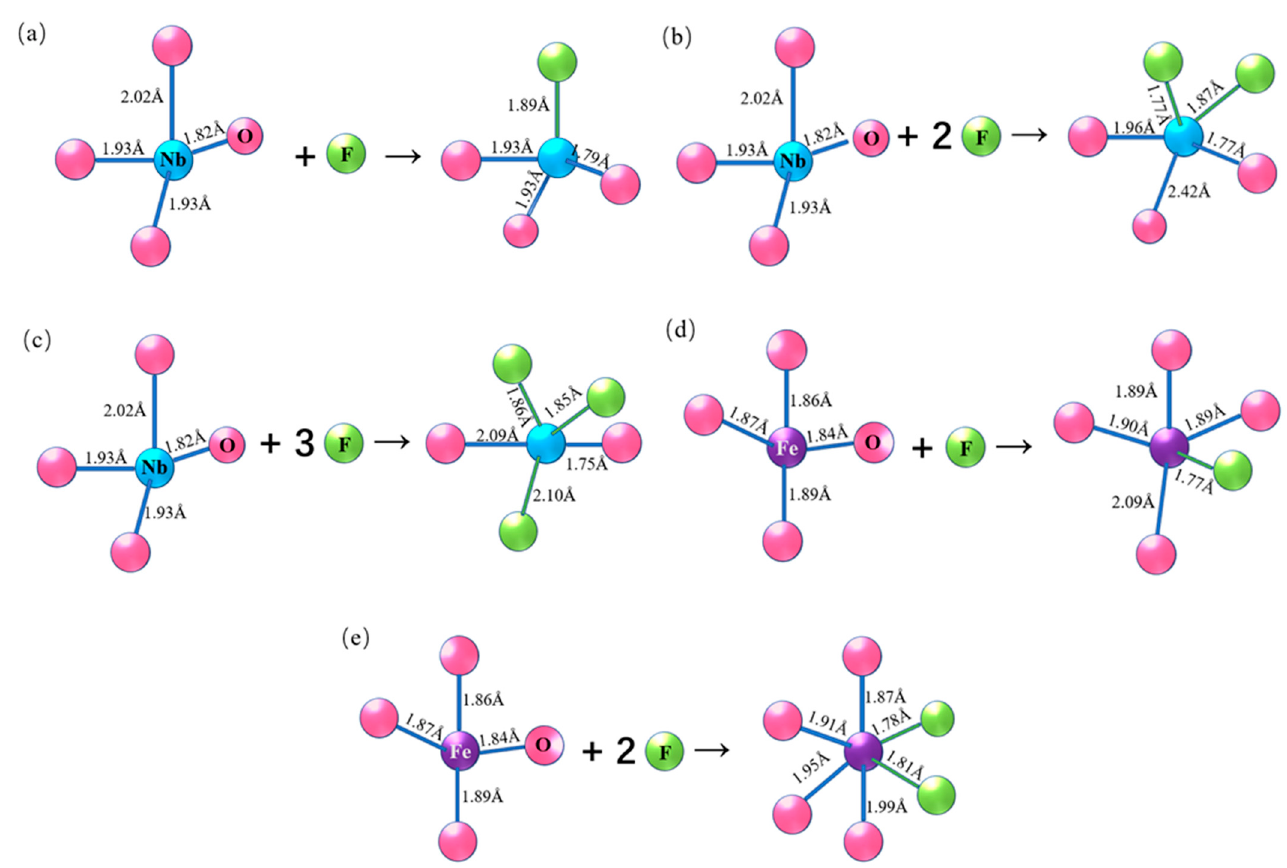
Figure 5. Diagram of Nb atoms and Fe atoms in columbite–(Fe) bonding with different numbers of F ions. ( a ) One F ion combined Nb atom; ( b ) 2 F ions combined with Nb atom; ( c ) 3 F ions combined with Nb atom; ( d ) 1 F atom was added near Fe (when 2 F and 3 F atoms were added in the system); and ( e ) When 2 F is added near Fe (4 F and 6 F atoms are added to the system).